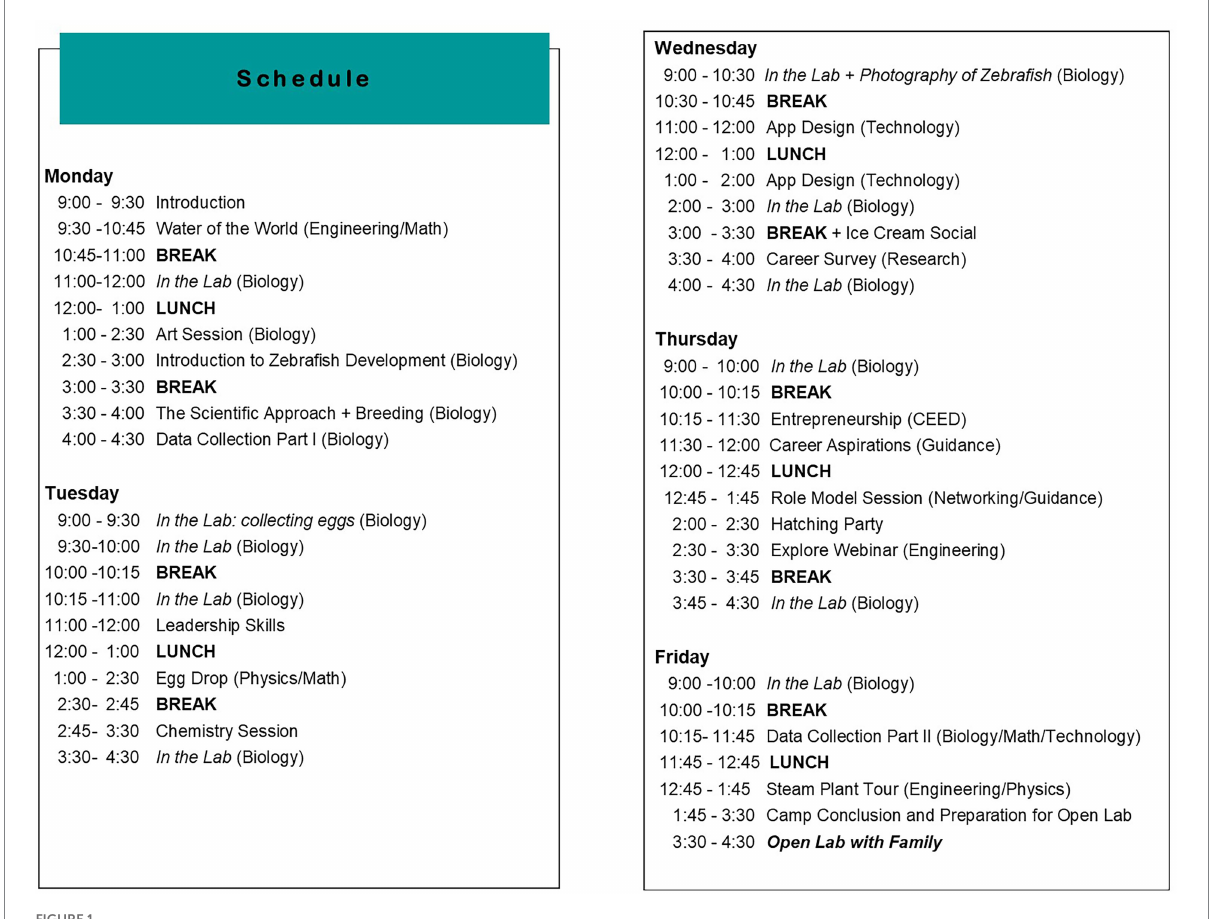
FIGURE 1 Example of a Junior Girls Get WISE Science Summer Camp program of